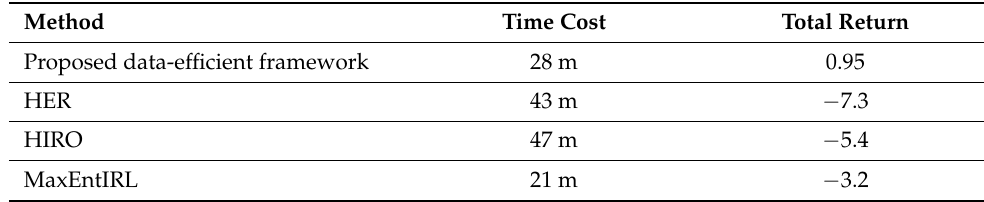
Table 3. Time cost and total